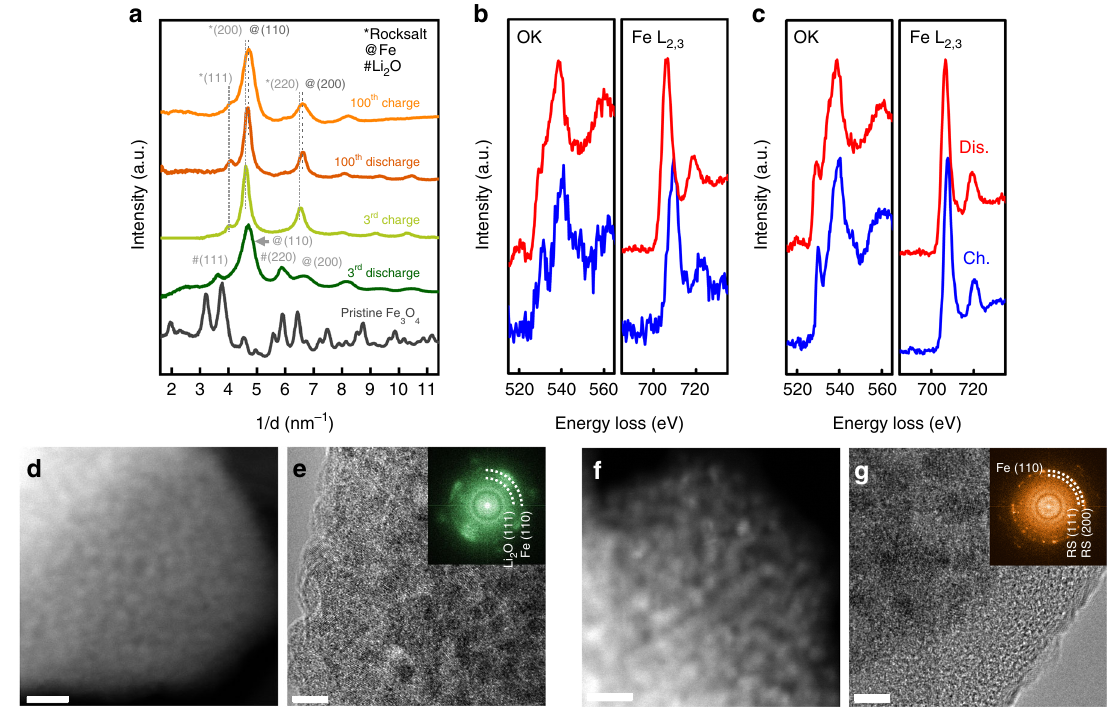
Fig. 5 Analytical characterization of ex situ cycled electrode after 3rd and 100th cycles. a Radial intensity pro fi les acquired from the SAED patterns of electrode at pristine state, discharged, and charge at the 3rd cycle and discharge and charge at the 100th cycle. EELS spectra showing valence changes of iron between discharged and charged states of electrode cycled b 3 times and c 100 times. Dis. and Ch. indicate discharged state and charged state, respectively. Typical morphology and corresponding FFT of d , e electrode after three cycles and f , g electrode after 100 cycles. RS at inset of g denotes rock-salt phase. Scale bars in d , f 10 nm, scale bars in e , g 5 nm